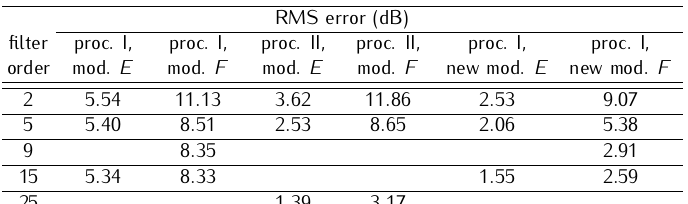
Table 1. RMS errors (deviations) between the PSDs of the filters designed by the procedure I and II using the corresponding design curves (modified E , modified F , new modified E and new modified F ) and the target curves (modified E and modified F )